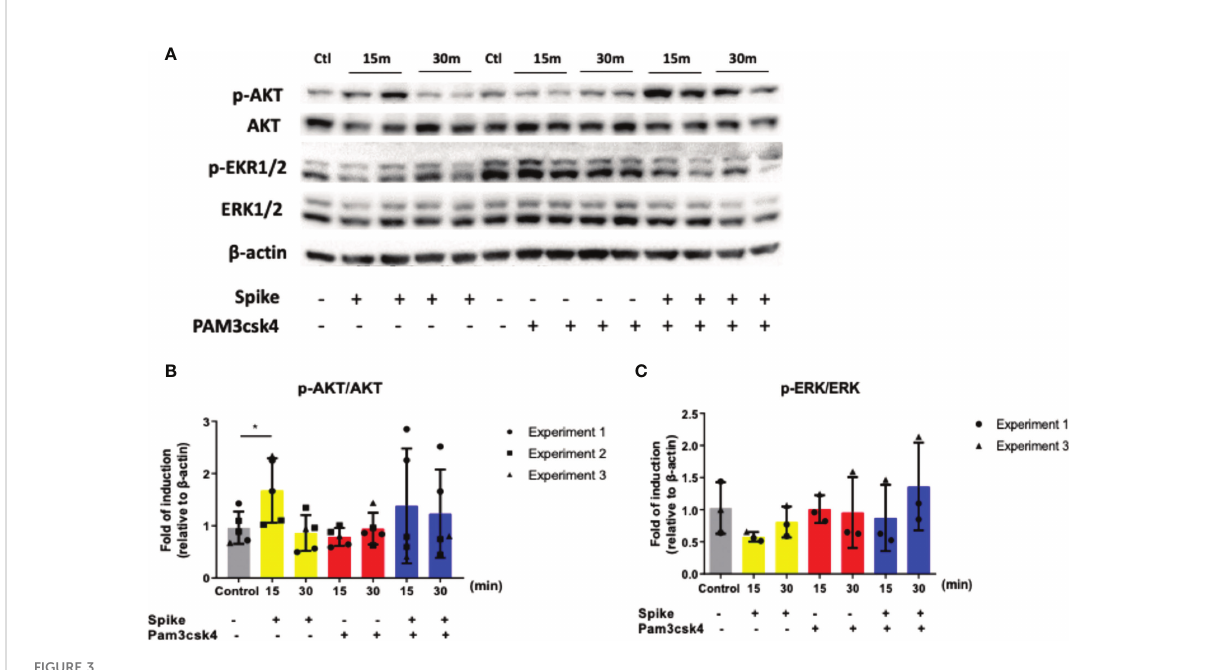
FIGURE 3 SARS-CoV-2 S protein triggered the induction of the PI3K/Akt pathway. A549 cells were treated with 50ng/ml SARS-CoV-2 S protein or PAM3csk4 or SARS-CoV-2 S and PAM3csk4 for 15 and 30 minutes. SARS-CoV-2 S protein slightly decreased the phosphorylation of ERK1/2 (A, C) , while signi fi cantly increased the phosphorylation of AKT (A, B) . Representative western blot (A) is presented and densitometry analysis from three (B) or two (C) independent experiments. Densitometry analysis is illustrated in bar graphs and plotted as mean ± S.D. Individual points indicate the biological replicates from all experiments (experiments 1 and 2 include two biological replicates for each condition and experiment 3 includes one biological replicate per condition). Statistical analysis was performed with t test (B) , but it was omitted for ERK due to the small sample size (C) . *p <